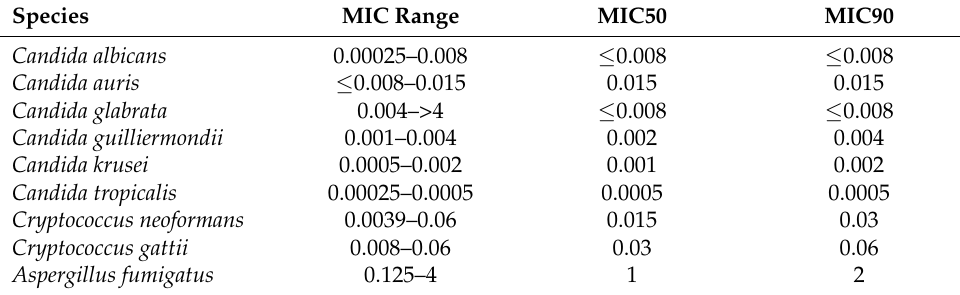
Table 2. In vitro activity of T-2307. The results for which data are available for >10 isolates are shown. The endpoint that was used in all studies was a prominent inhibition of growth, and MICs are in µ g/mL. MIC50 and MIC90 values represent MIC values at which 50% and 90% of the tested isolates were, respectively,